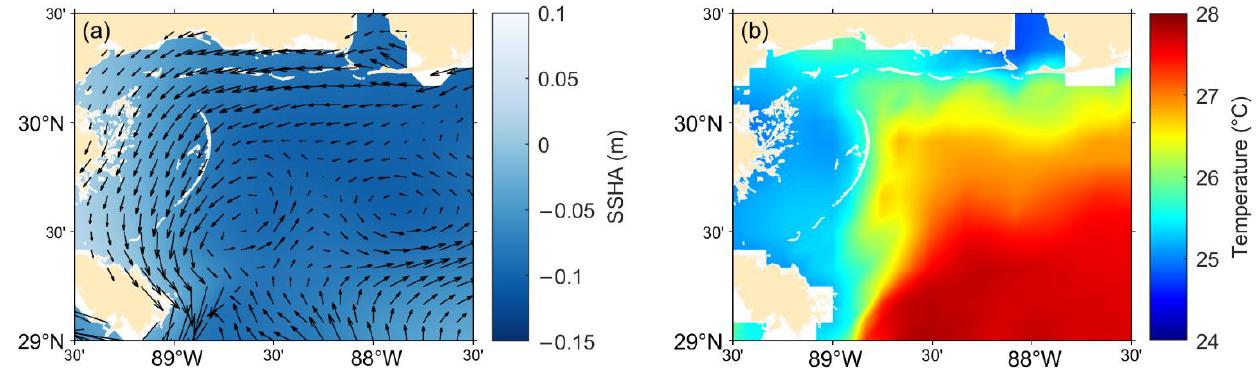
Figure 11. The maps of sea surface height anomaly, currents and temperature on 4 October 2011. ( a ) Sea surface height anomaly and current velocity on 4 October 2011. Arrows represent water flow vectors, SSHA is distinguished by the color bar; ( b ) Sea Surface Temperature on 4 October 2011.